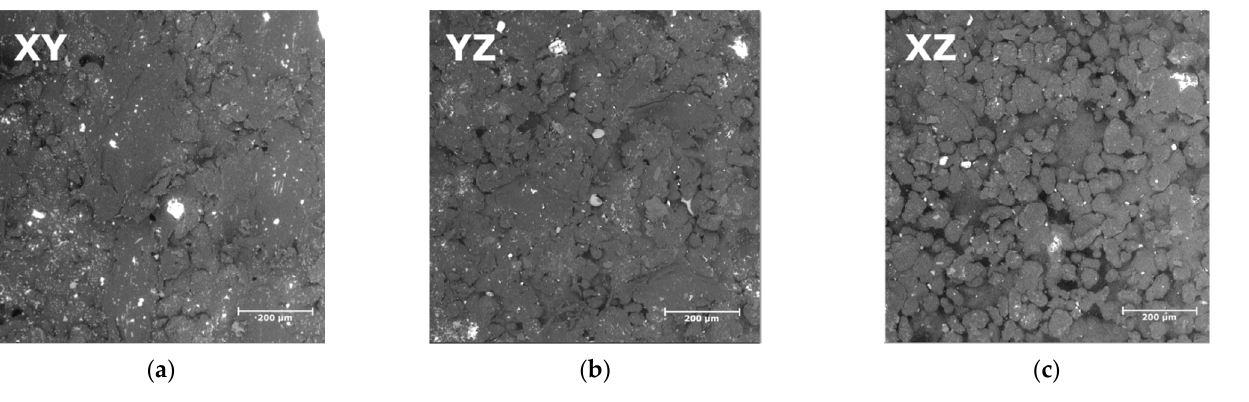
Figure 6. Typical micrographs of fracture surface for the test samples printed in XY ( a ), YZ ( b ), and XZ ( c ) directions.